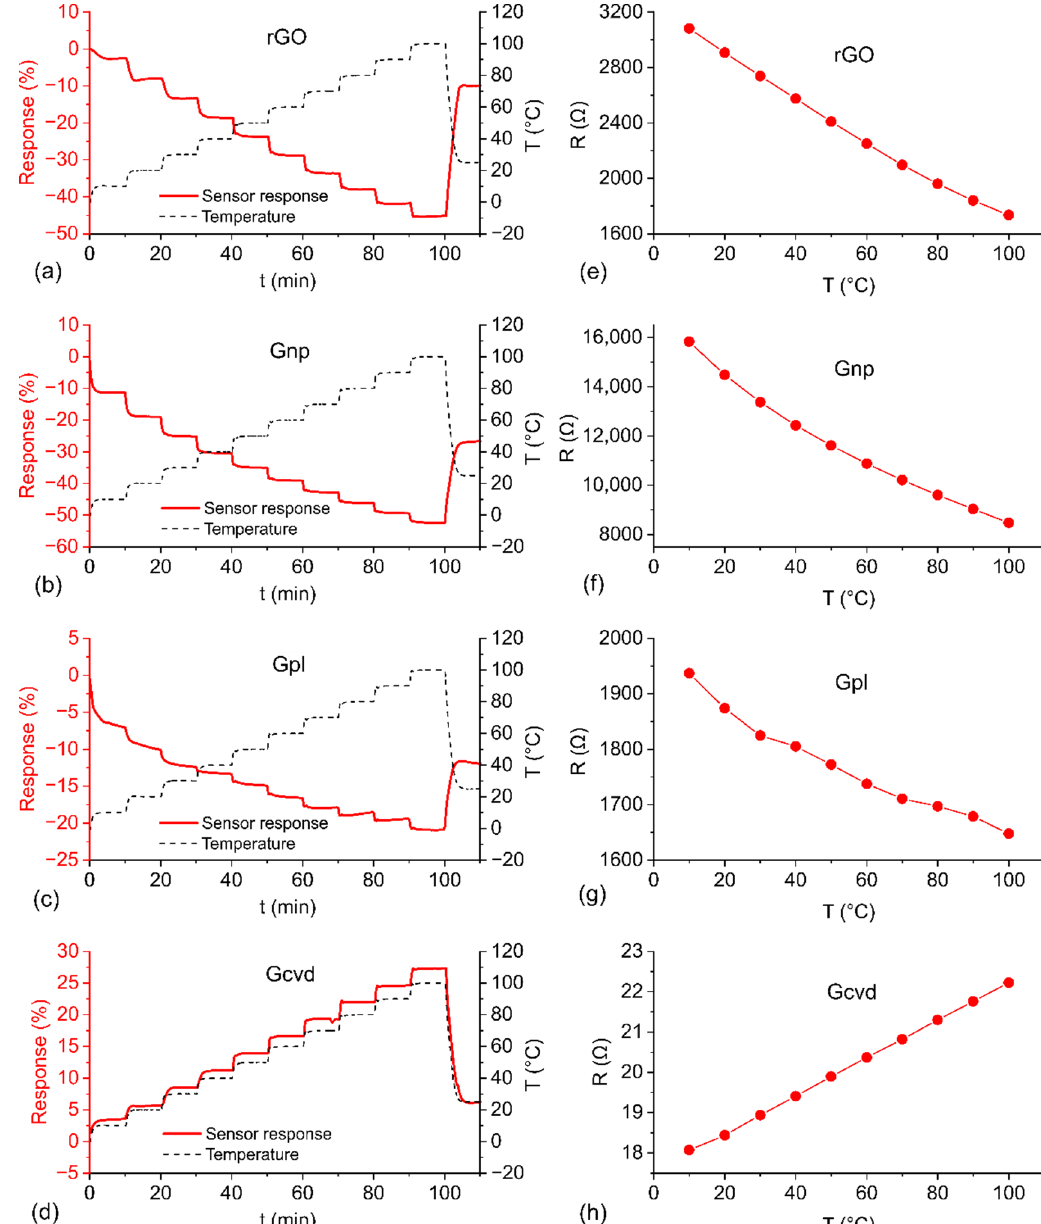
Figure 4. Summary of the time dependences of relative changes in resistance and temperature during climatic testing for ( a ) rGO, ( b ) Gnp, ( c ) Gpl, and ( d ) Gcvd and the temperature dependences of steady-state resistance at each step of testing for ( e ) rGO, ( f ) Gnp, ( g ) Gpl, and ( h ) Gcvd. Table 2. Temperature and humidity parameters of graphene-based materials.